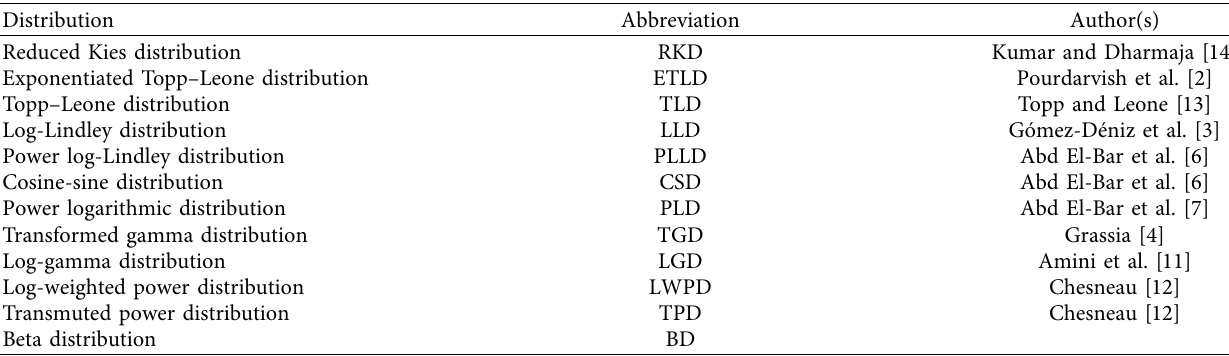
Table 7: List of the compared